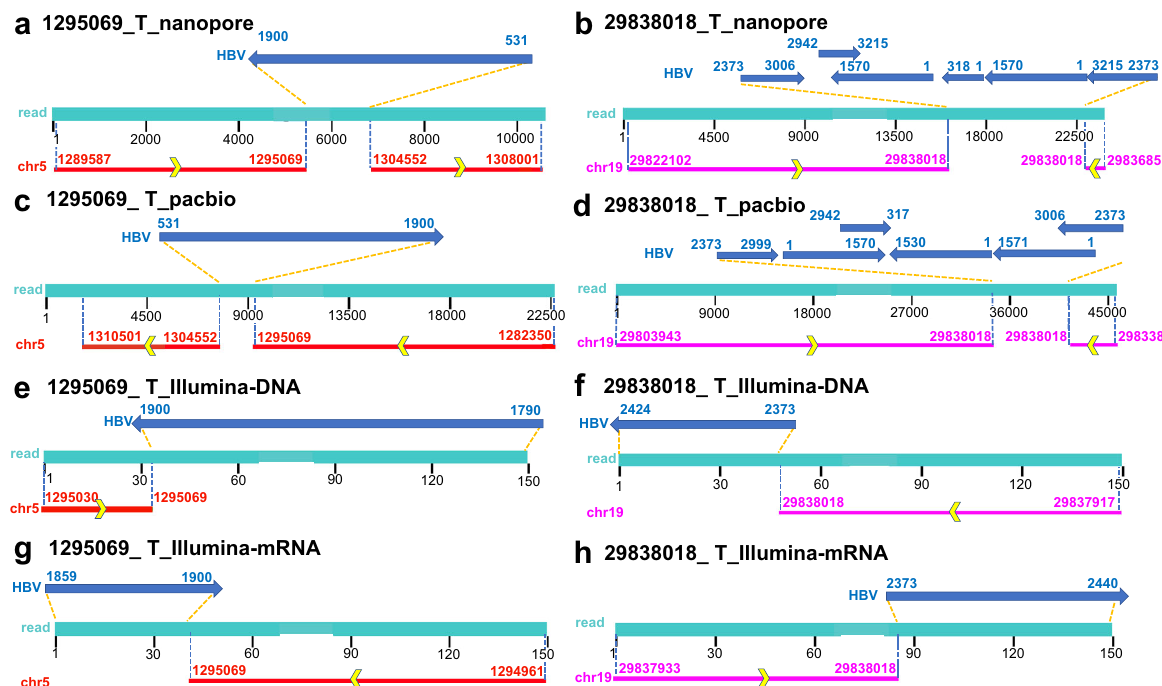
Fig. 2 Locations of representative HBV-human chimeric reads in the HBV and human genome. a , c , e , g HBV: 1900, chr5: 1295069 detected in Nanopore, PacBio, Illumina (DNA), Illumina(mRNA) platforms. b , d , f , h HBV: 2373, chr19: 2983018 detected in Nanopore, PacBio, Illumina (DNA), Illumina(mRNA) platforms.